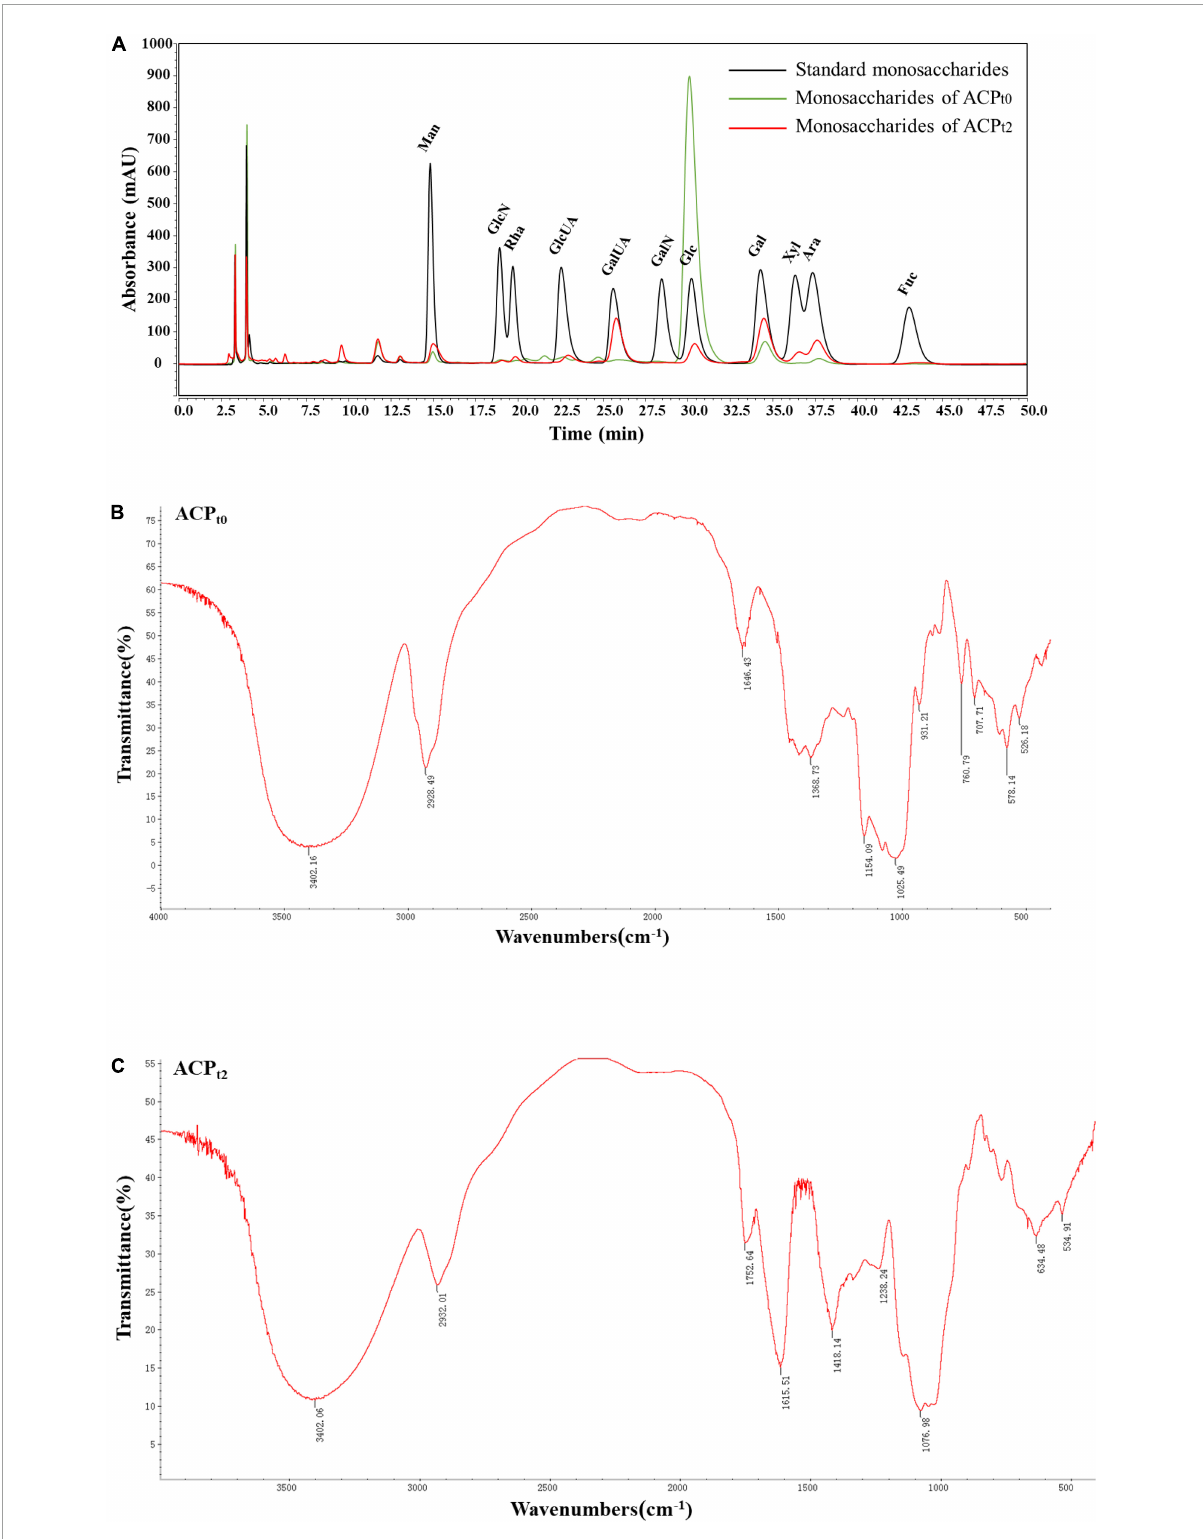
FIGURE2 (A) Ion chromatogram data of monosaccharide composition of ACP t 0 and ACP t 2 , Fourier-transform infrared (FT-IR) spectra of ACP t 0 (B) , and ACP t 2 (C) in the range of 4000–400 cm − 1